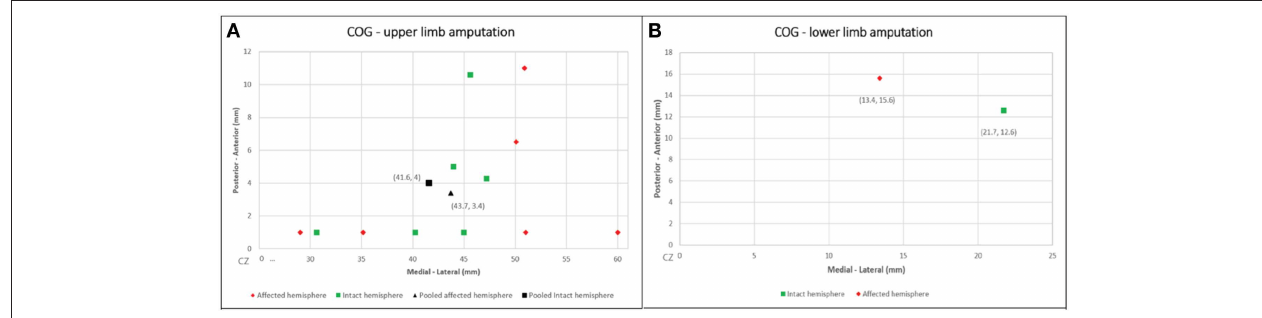
FIGURE 2 | Cartesian plots presenting the CoG coordinates from the included studies and the pooled calculation. (A) Upper-limb amputation; (B) lower-limb amputation.